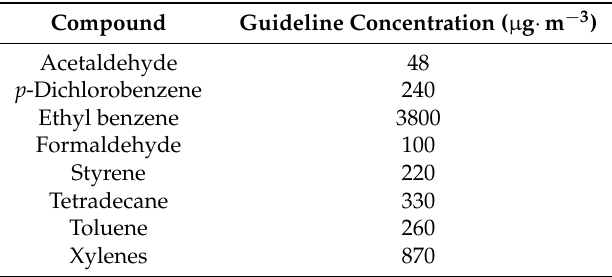
Table 1. Guideline indoor air values established by the Japanese Ministry of Health, Labour and Welfare for the target volatile organic compounds